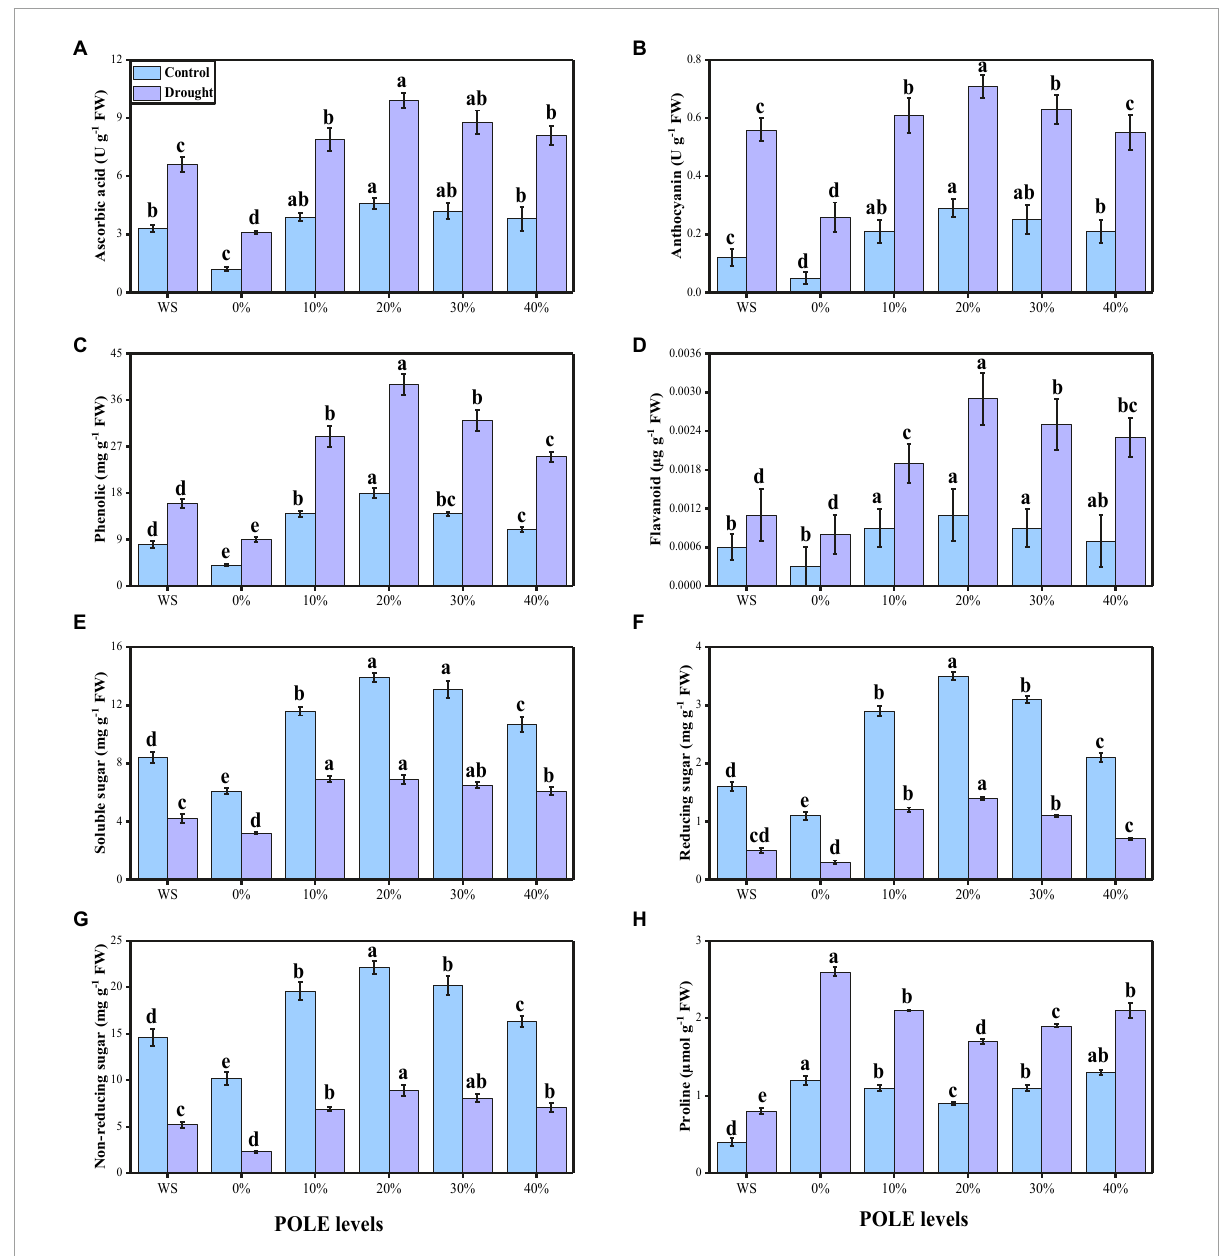
FIGURE7 Effect of seed priming with Plantago ovata Forsk leaf extract (POLE) on ascorbic acid contents (A) , anthocyanin contents (B) , phenolic contents (C) , flavonoid contents (D) , soluble sugar contents (E) , reducing sugar contents (F) , non-reducing sugar contents (G) , and proline contents (H) under well-watered and drought-stressed environment in wheat. Means sharing similar letter(s) within a column for each parameter do not differ significantly at P < 0.05. Data in the figures are means of four repeats ( n = 4) of just one harvest of wheat plants ± standard deviation (SD). Different lowercase letters on the error bars indicate significant difference between the treatments. Different treatments of POLE used in this study are as follows: WS (Control, without POLE + without water), 0% (0% POLE), 10% (10% POLE), 20% (20% POLE), 30% (30% POLE), and 40% (40%